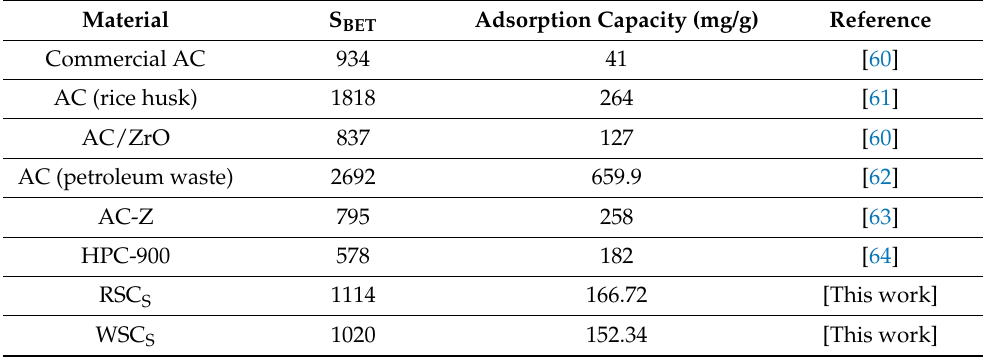
Table 3. The adsorption capacity of the prepared biochars compared to data from the literature.